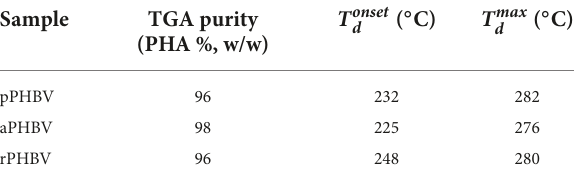
TABLE 3 Purity values (based on TGA) and thermal stability of PHBV extracted from the wasted bread/seawater substrate with different methods ( Figure 1 ): pPHBV, sample obtained from the CHCl 3 :H2O separation and the precipitation with cold ethanol; rPHBV, obtained by the replacement of the CHCl 3 :H2O separation with repeated washing with water; aPHBV, obtained by the replacement of the CHCl 3 :H2O separation with repeated washing with water, but followed by solubilization in CHCl 3 and purification with cold